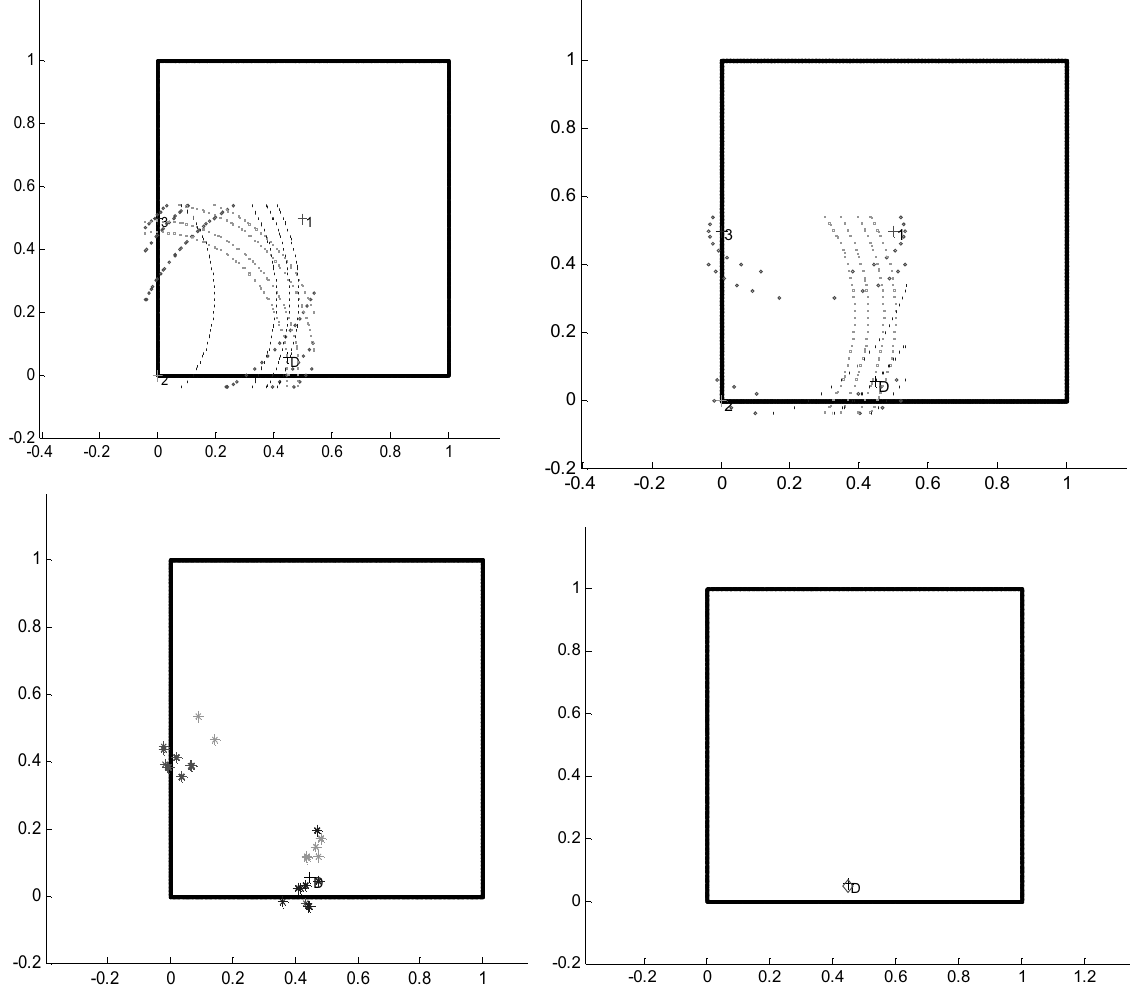
Fig. 15. Damage algorithm executed by the software – determination of most probable damage location (ellipses and intersections). Cuts initiating in rivet holes and also the ones connecting adjacent rivets were successfully detected, as long as they are not behind the rivets with relation to the network. Specifically, cuts aligned with the network were only detected when their length was over 2 mm, due to a minimum required time separation between their reflection and the contiguous rivet hole generated reflection. The minimum required separation time is dependent on the maximum sampling frequencyof acquisition of the sensor signals by the oscilloscope (NI digitizer), in this case 60MS/s, and the wave propagationspeed – and also on the minimum number of sampled points for the software reliably determine the existence of such reflection. Loosen rivets were also detect by this method. The positions of these types of damages (cuts originating in rivets, connecting adjacent rivets and loosen rivets) were determined with success, although it was verified a diminished precision in the determination of their radial position with relation to the network. Finally it was observed that, with the introduction of the stringer, damages created beyond it, with relation to the network, were not detected, since their reflections were destroyed (reflected) by the stringer and the rivets line. For the smallest damage reliably detected, corresponding to a circular surface hole of 1 mm of diameter, the different steps in the process of determining the ellipses are presented in Fig. 15. Ellipses with foci in different pairs of PZT transducers are presented with different colors. These steps are executed after the detection of differences in the sensor signals between damaged and undamaged states. They are performed internally and automatically